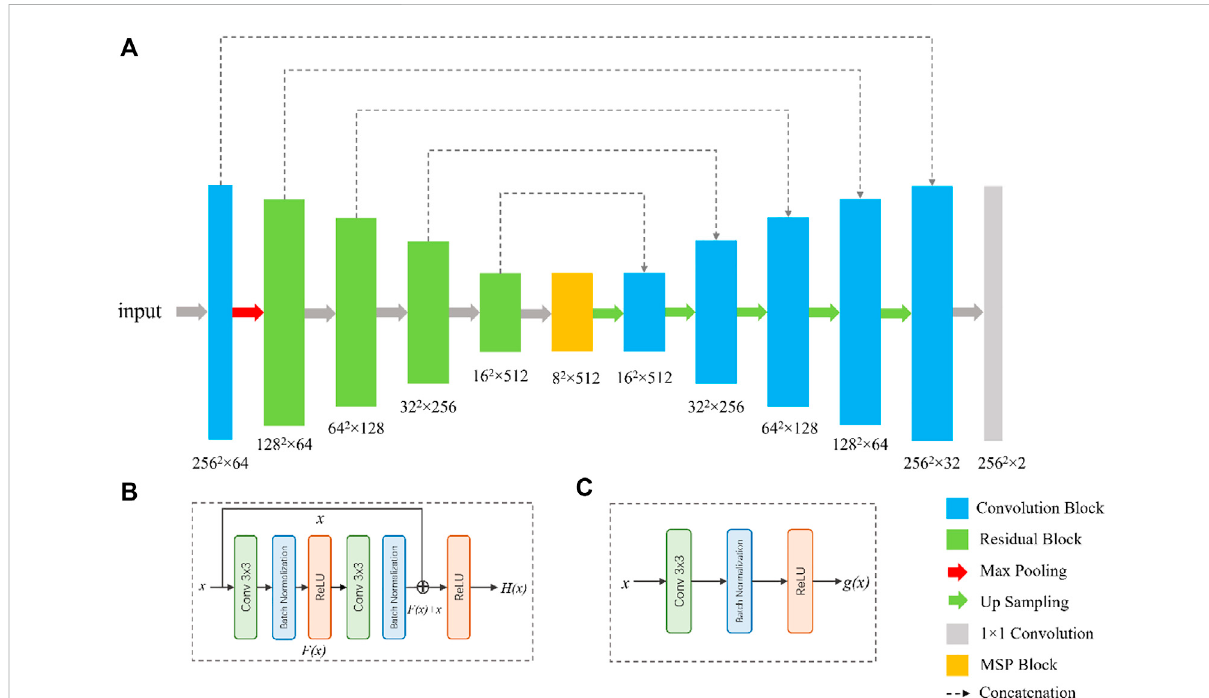
FIGURE 2 Network architecture for the segmentation of tear meniscus. The network (A) is a U-Net-like architecture with a modi fi ed ResNet-34 as encoder. The bottom of the network is multi-scale perception block (MSP). (B) and (C) are the illustrations of the residual block and convolution block,